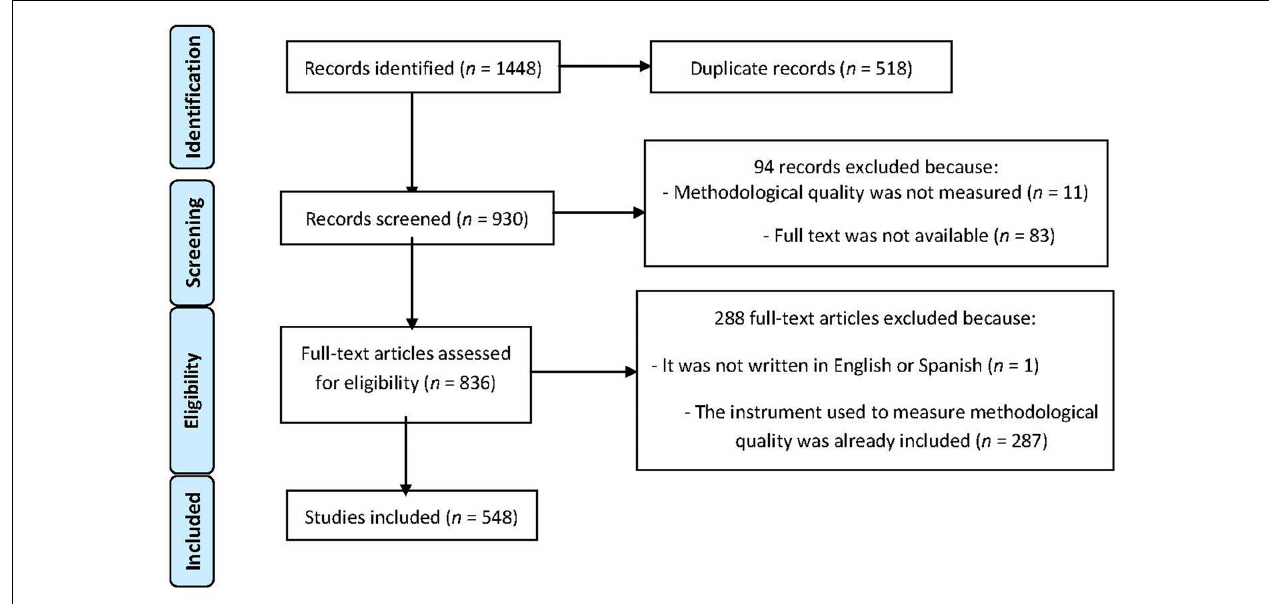
FIGURE 1 | Flow chart in the search for papers (Moher et al.,